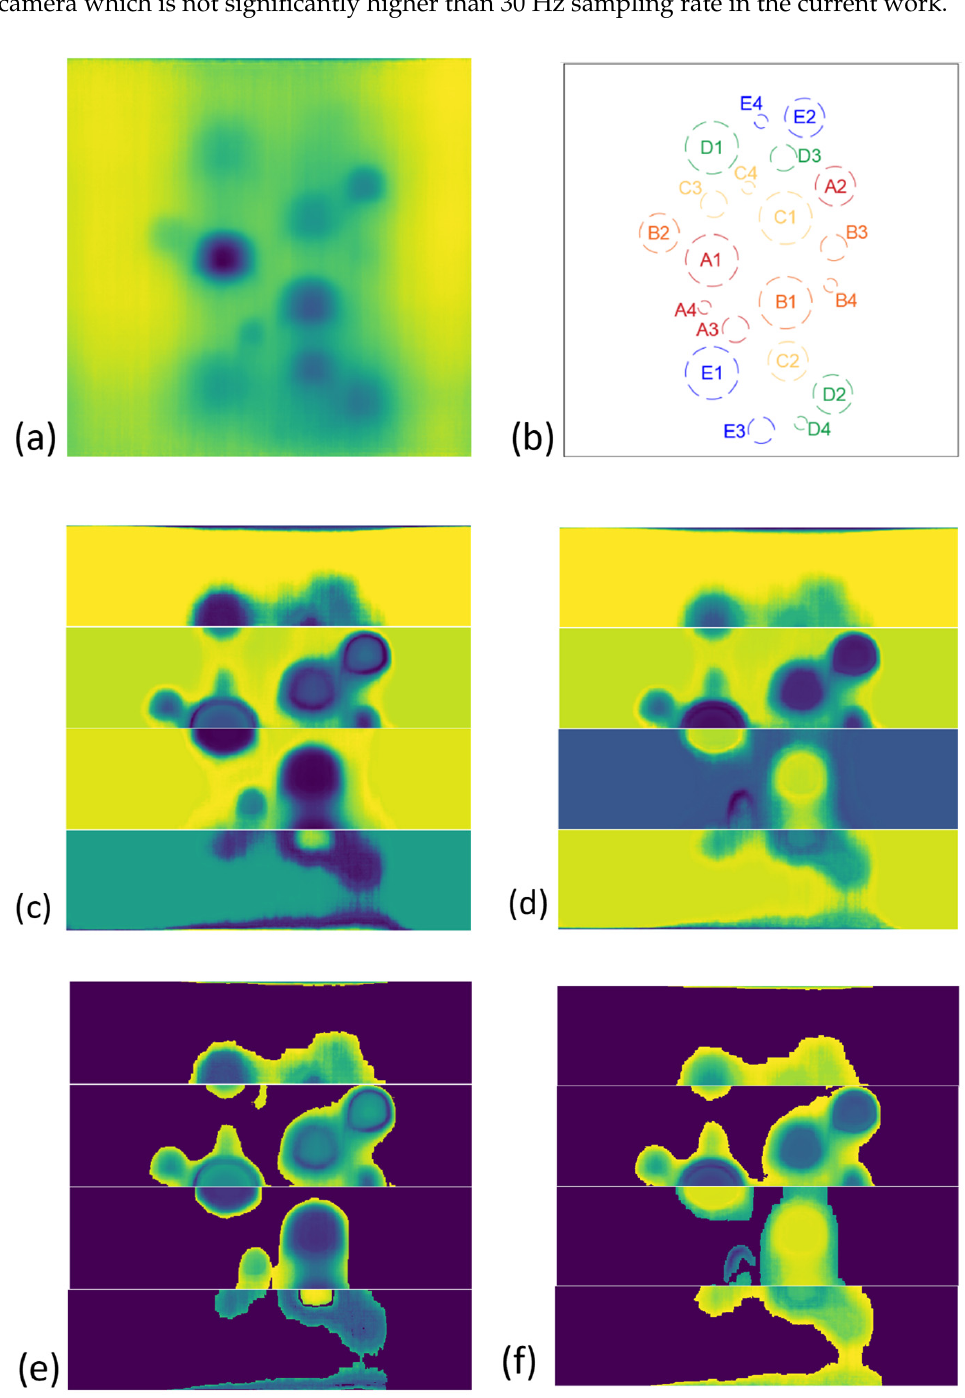
Figure 14. ( a ) the test piece original full-frame thermal image; ( b ) defects schematic; ( c , d ) the first and second PCA of time-transient DRR selected images; ( e , f ) respective GMM segmented PCA images.